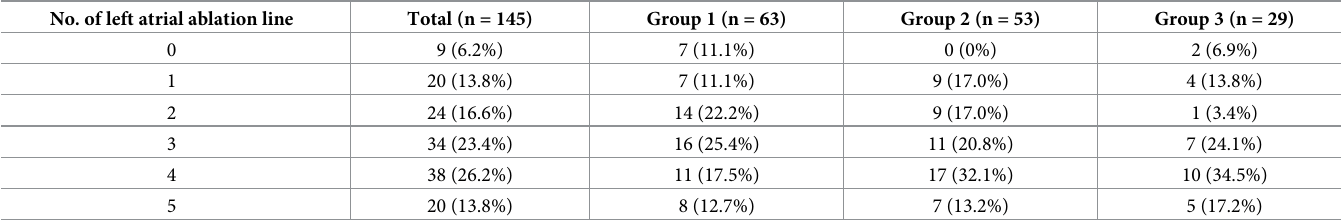
Procedures of LA linear ablation Tables 3 and 4 summarizes the number of patients undergoing LA linear ablation for various extents and locations. The mean number of ablation lines was highest in Group 3 (2.59 ± 1.53, 3.08 ± 1.31, and 3.31 ± 1.39 in Groups 1, 2, and 3, respectively, P = 0.048), and the ratio of patients undergoing different number of ablation lines were also significantly different among the three groups (Table 3, P = 0.038). That is, patients with a poorer ablation outcome under- went more lines of ablation. In 9 patients without undergoing LA linear ablation, 7 patients Table 3. Distribution of the percentage of patients undergoing different numbers of left atrial linear ablation among three groups. No. of left atrial ablation